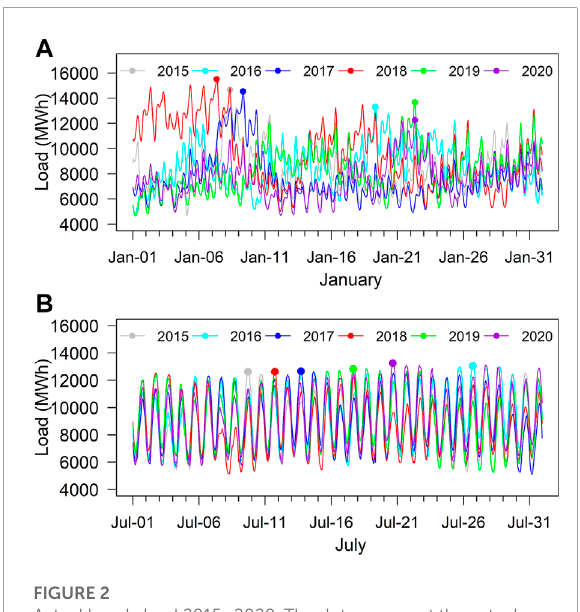
FIGURE 2 Actual hourly load 2015–2020. The dots represent the actual peak hours in (A) January and (B) July.